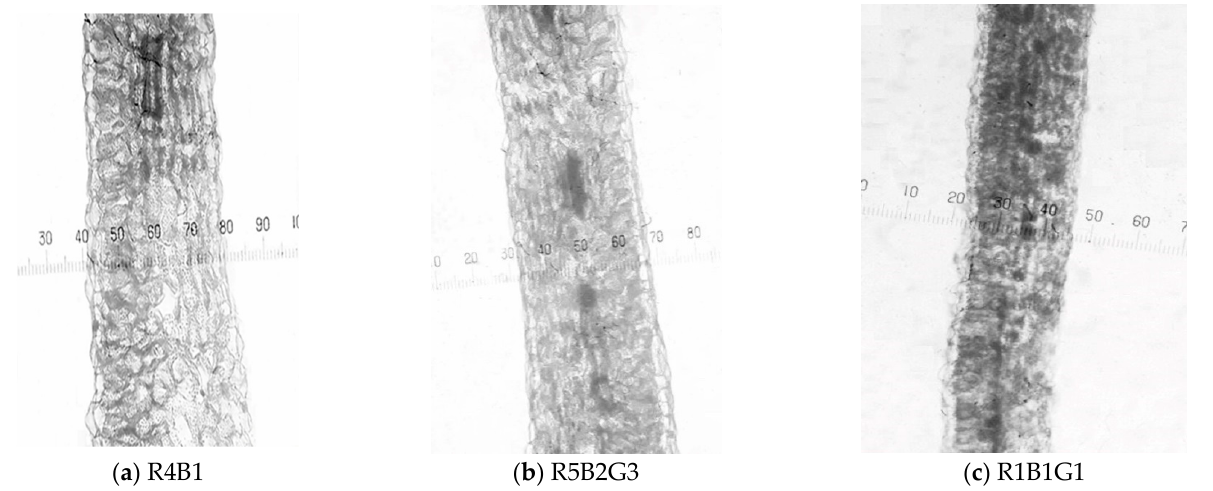
Figure 1. Anatomy of the spinach leaf cross-section at different light qualities: ( a ) R4B1, ( b ) R5B2G3 and ( c ) R1B1G1. Scale bar is 50 µm.